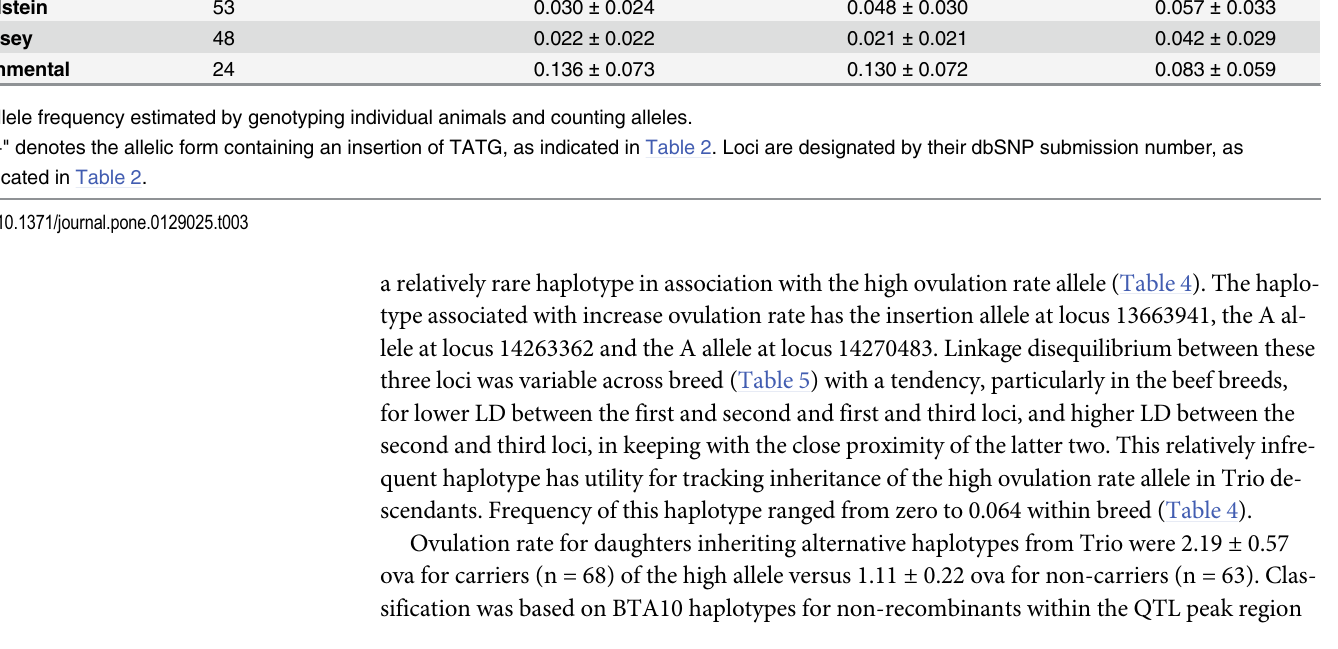
Table 4. Frequency of haplotypes by breed. 1,2